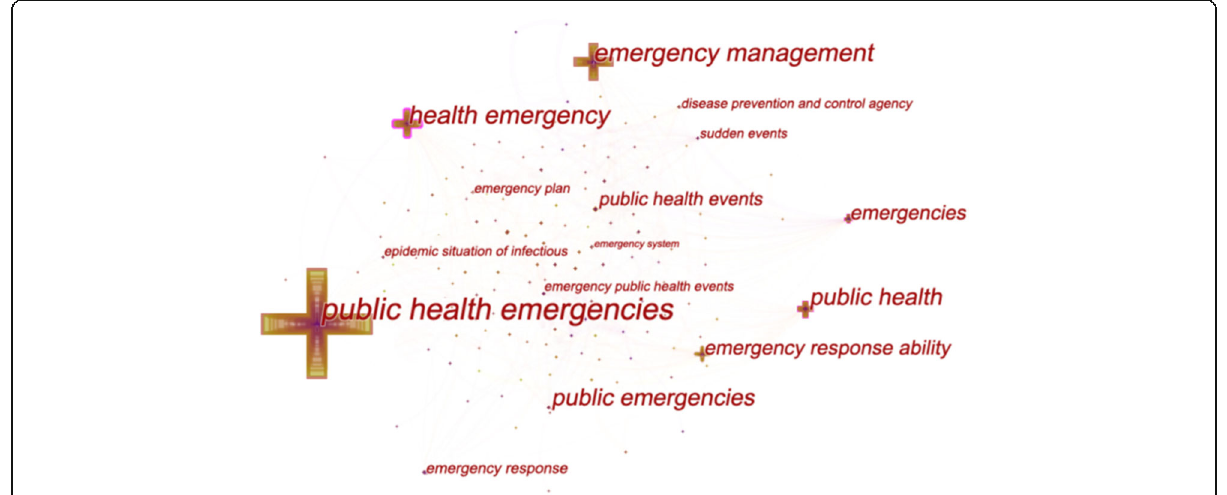
Fig. 8 Keywords co-occurrence network of Chinese database. The colors of crosses of a circle are corresponding to the year. The size of nodes represent research frequency of the